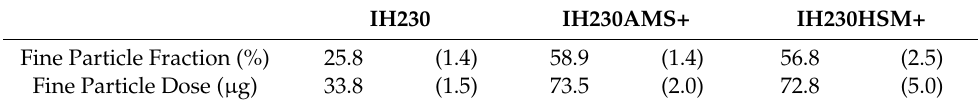
Table 5. FPF and FPD of interactive blends of all prepared adhesive mixtures. n = 5, SD in parentheses.